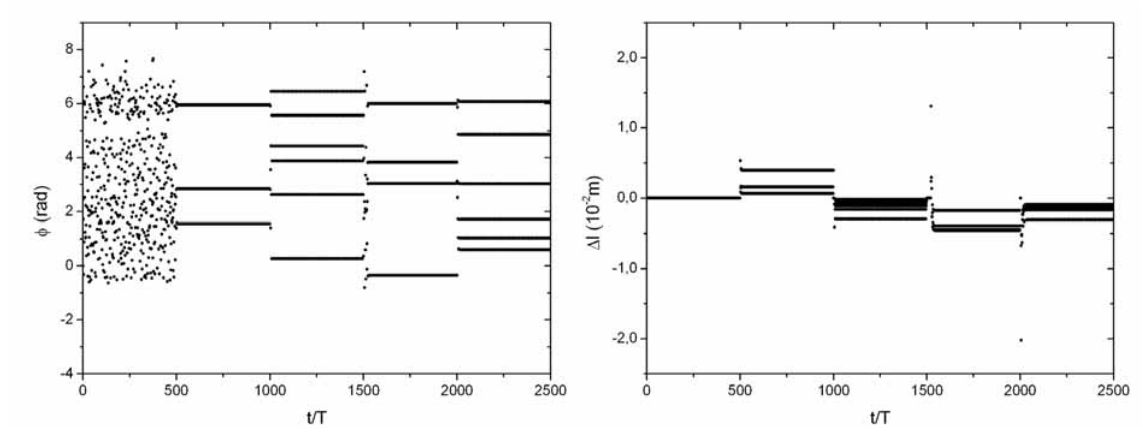
Fig. 6. Response under control. (a) Position of UPOs in Poincar´e section #1. (b) Control